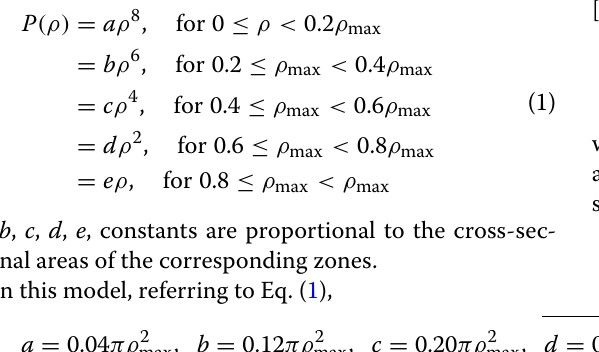
responding to the polar coordinates ( r , θ ). The Fourier transform lens has focal length